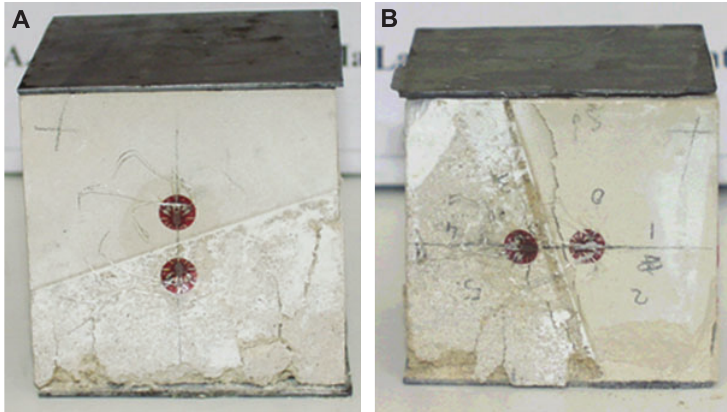
Figure 17 Typical tested prismatic composite specimens. (A) θ = 15 ° : The failure of the original stone (lower part of the specimen) is clearly visible. The substitute material is intact. (B) θ = 75 ° : The failure started from the substitute material (right part of the specimen) very close to the interface. The original material remained almost